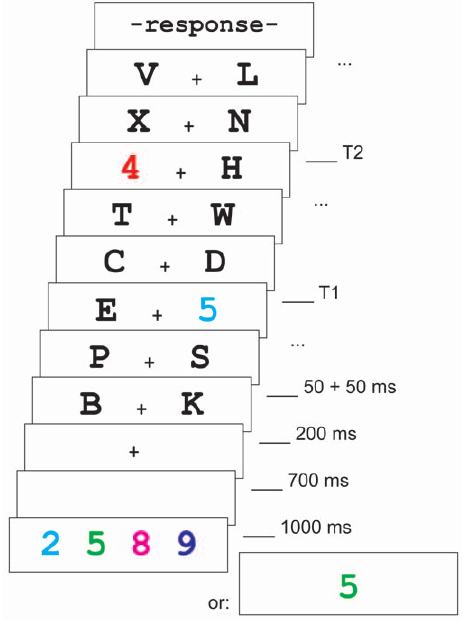
Figure 1. The experimental procedure as used in Experiment 1. The trial is depicted from the onset of the memory set (100 ms after trial start) until the onset of the response screens (max. 1500 ms each). One or more similar frames are indicated with dots (‘‘…’’). The colors are not meant to precisely reflect the actual RGB values used in the experiment and are provided for illustration purposes